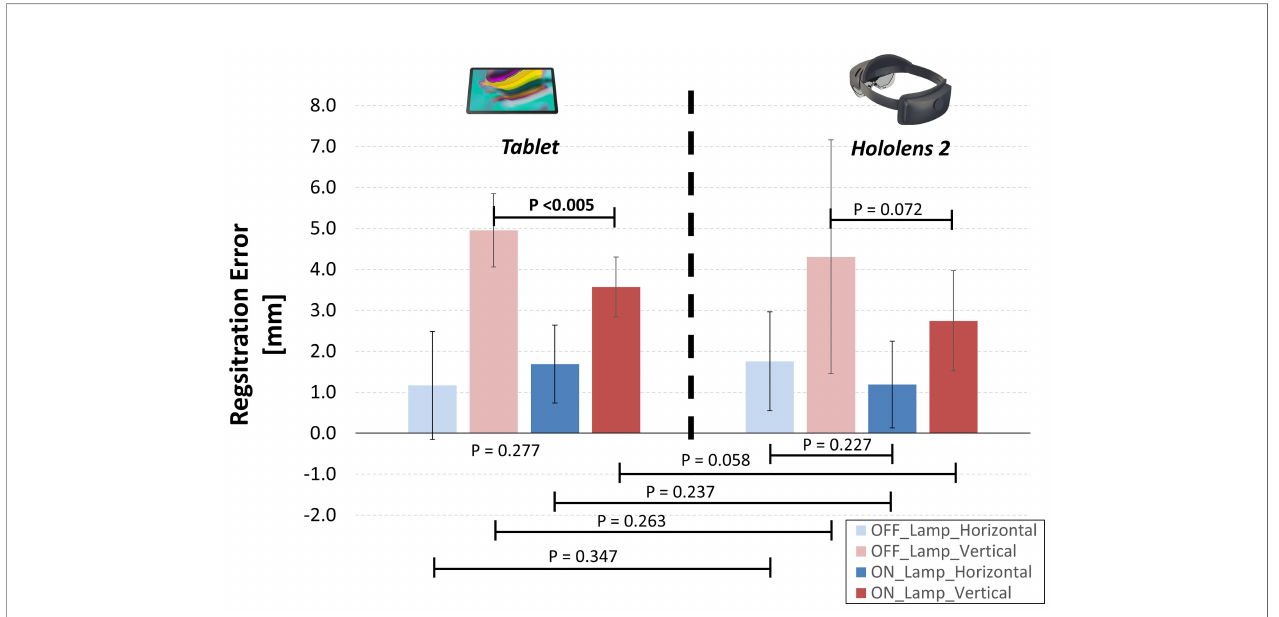
FIGURE 9 | Resulting registration errors calculated as mean horizontal and vertical deviations between the real and virtual content, for two lighting conditions: environment illuminated by natural daylight (OFF_Lamp); arti fi cial lamp light that points directly on the phantom